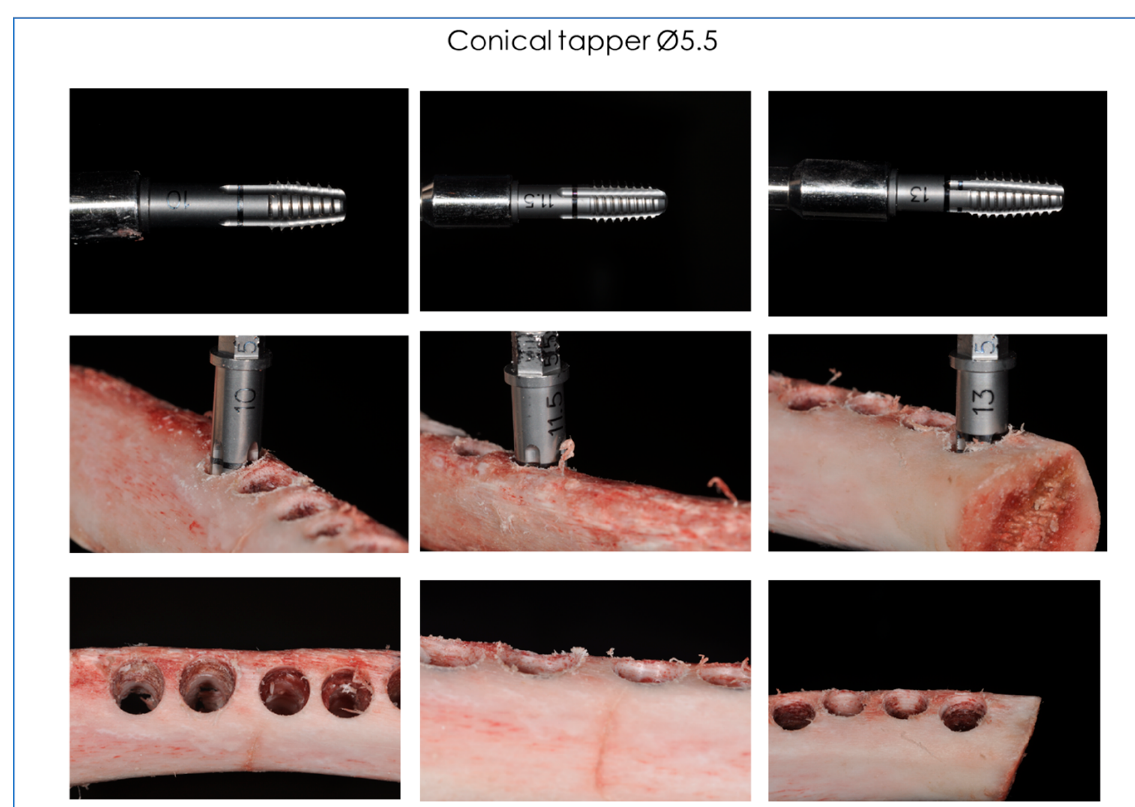
Figure 6. Details of the conical tappers (continued) .